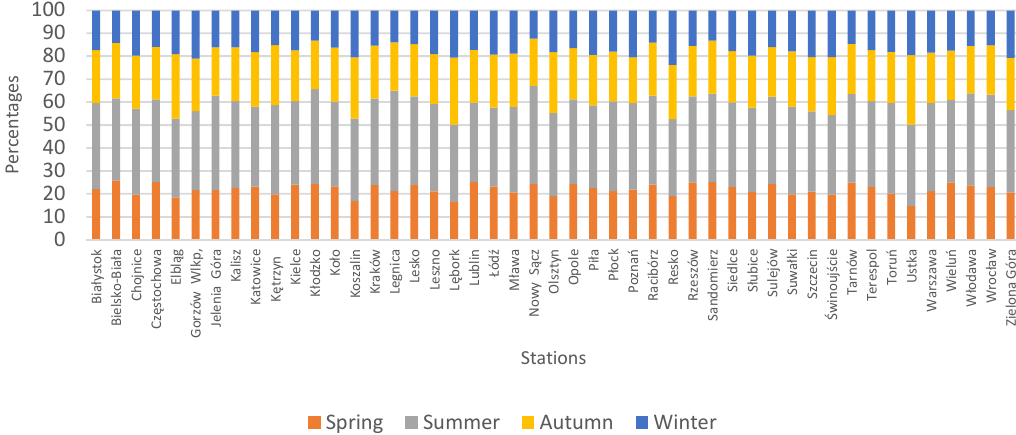
Figure 4. Percentage share (%) of seasonal precipitation in the annual total in 2001–2018.